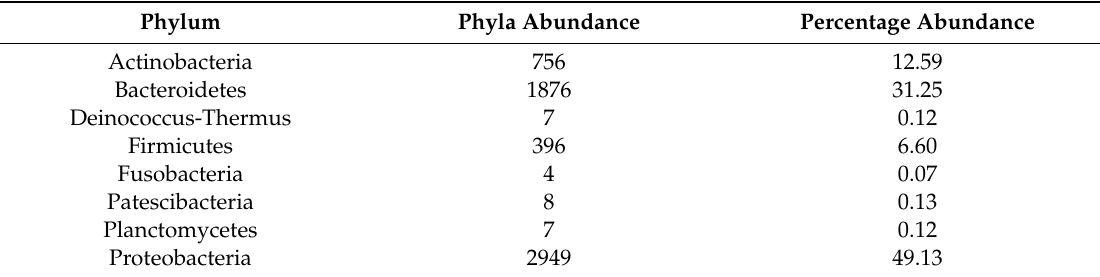
Table 1. Abundance and percentage abundances of phyla present in spinach leaf samples identified from 16S rRNA gene sequences analyzed using DADA2 package in R and taxonomic assignment performed according to the SILVA rRNA